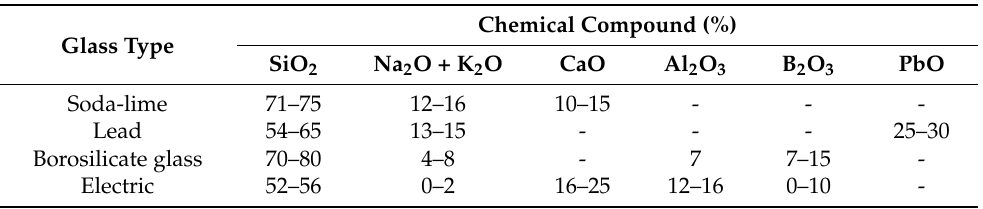
Table 6. Chemical composition of various kinds of waste glass [77].